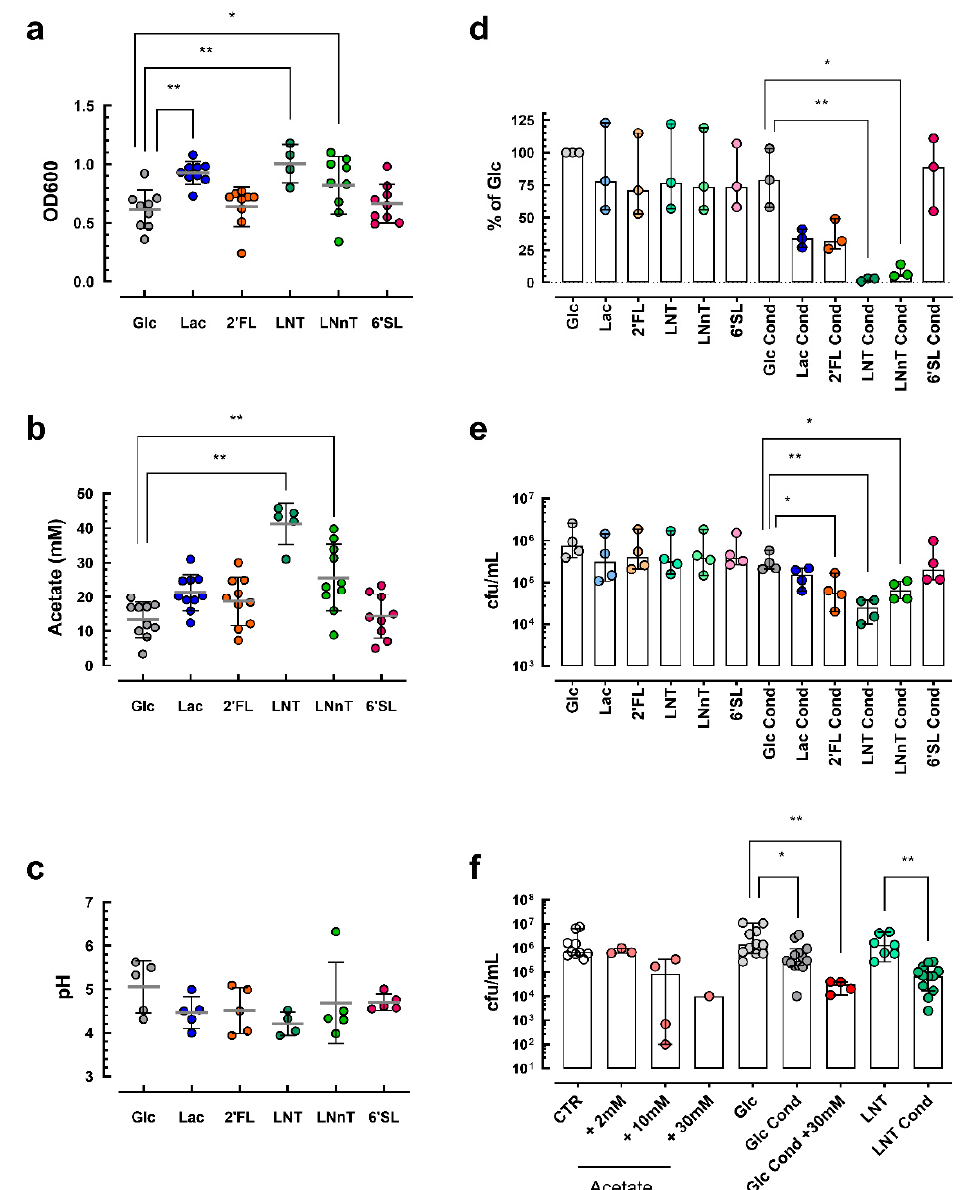
Figure 6. In vitro experiments with B. longum subsp. infantis conditioned with glucose (Glc), lactose (Lac), 2 ′ fucosyllactose (2 ′ FL), lacto-N-tetraose (LNT), lacto-N-neotetraose (LNnT) and 6 ′ sialyllactose (6 ′ SL): ( a ) bacterial growth monitoring using optical density at 600 nm (OD600); ( b ) quantification of acetate in spent culture media from conditioned B. longum subsp. infantis ; ( c ) measurement of conditioned spent culture medium pH; ( d ) measurement of NFkB activation by TNF α in the presence of control and conditioned (cond) spent culture media; ( e ) measurement of Salmonella invasion in cultured epithelial cells in the presence of control and conditioned spent culture media; ( f ) measurement of Salmonella invasion with different amounts of acetate added to fresh or spent culture media in comparison to control and spent culture media. Symbols stand for independent experiments each with 3 replicates (* p < 0.05, ** p < 0.01 by Kruskal–Wallis or non-parametric t -test).